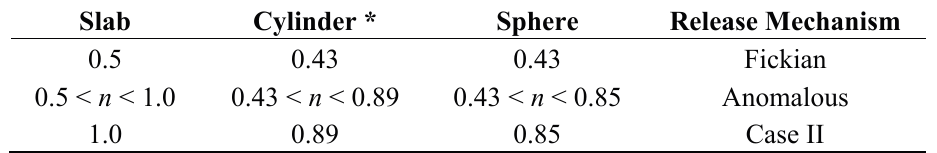
Table 1. Diffusional exponent values for various geometries and release